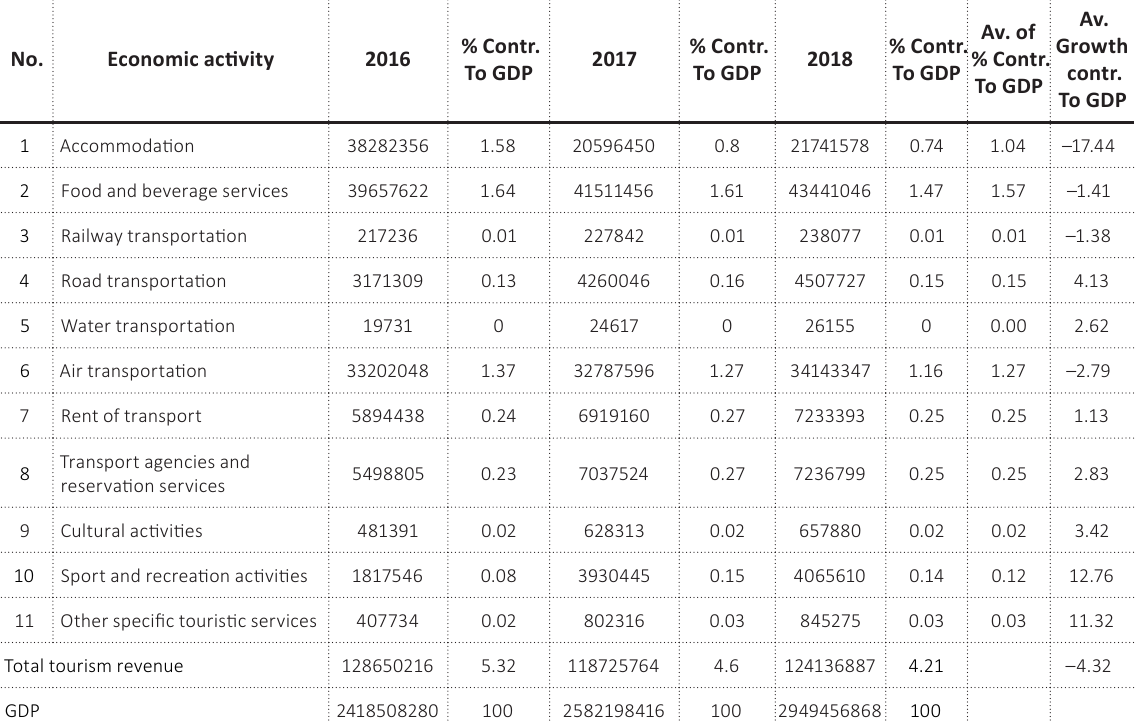
Source: General Authority for Statistics (2021).